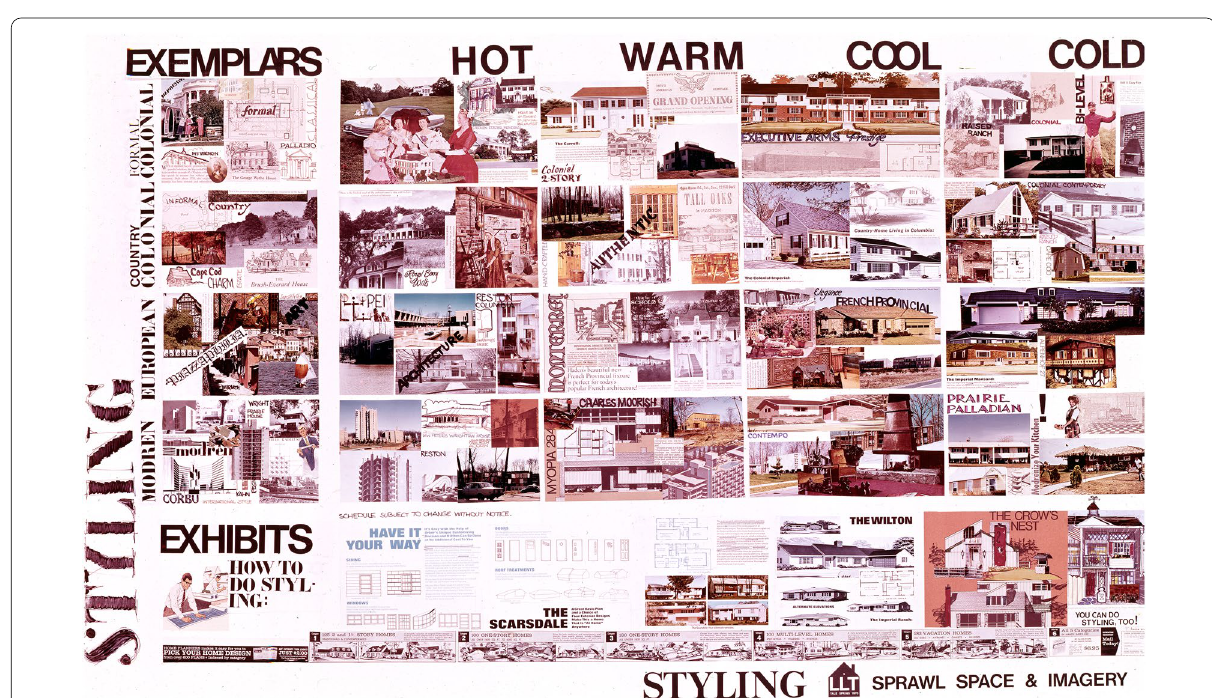
Fig. 5 Robert Venturi, Denise Scott Brown, and Steven Izenour, learning from Levittown Studio, Fall 1970. Life styles expressed in the house. Credits: Venturi, Scott Brown Collection, The Architectural Archives, University of Pennsylvania. https:// www. design. upenn. edu/ archi tectu ral‑ archi ves/ ventu ri‑ scott‑ brown‑ and‑ assoc